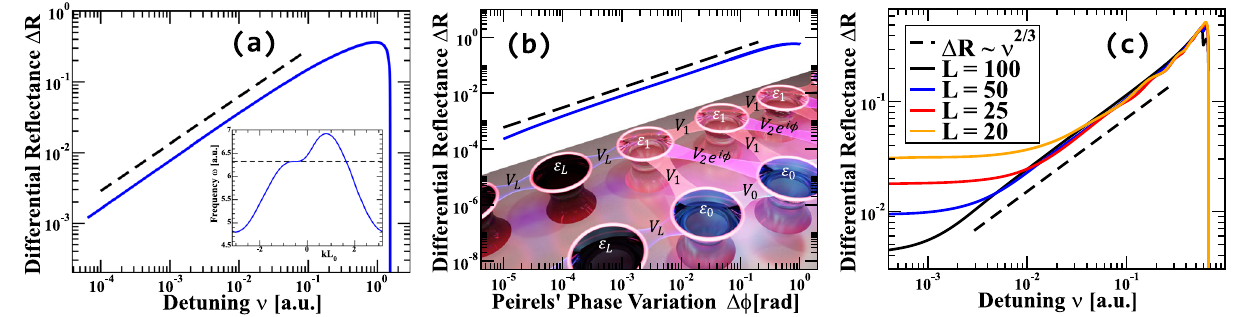
Fig. 3 Differential re fl ectance near SIP frequency obtained from two-chain CMT model. a Logarithmic plot of the differential re fl ectance Δ R (blue line) as a function of the frequency detuning ν from the stationary in fl ection point (SIP) frequency ω SP . The black dashed line indicates a variation of the differential re fl ectance which is Δ R / ν j j 0 : 66 . The inset shows the dispersion relation of the Coupled Mode Theory (CMT) model. The SIP frequency ω SP is indicated by a horizontal dashed line. b Logarithmic plot of the differential re fl ectance Δ R (blue line) as a function of the Peirels ’ phase detuning ν ¼ Δ ϕ from the critical phase ϕ . The black dashed line indicates a variation of the differential re fl ectance which is Δ R / ν j j 0 : 66 . In the background we show a schematic of the CMT model SP Eq. (12). c Logarithmic plot of the differential re fl ectance Δ R (color lines) as a function of the frequency detuning ν from the SIP frequency ω SP in case of a fi nite- size system for various number of unit-cells L . The black dashed line indicates a variation of the differential re fl ectance which is Δ R / ν j j 0 : 66 . In order to optimize (cid:4) (cid:5) 2 , where γ n (cid:5) 1 the scaling performance, we have used a ramped loss γ n ð Þ ¼ γ is the amount of loss in the last unit cell and n is the number of the unit L (cid:5) 1 max max